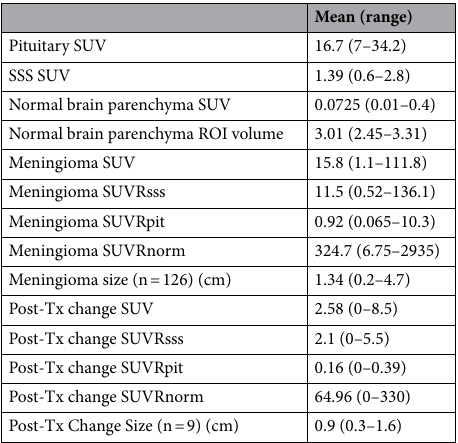
Table 2. Descriptive analysis of the target lesions. Only a subset (n = 9) of the post-treatment change lesions had its size information available.